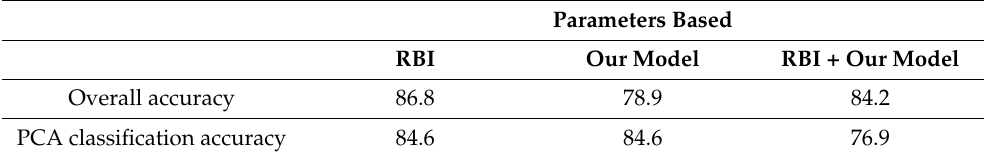
Table 2. Model Accuracy